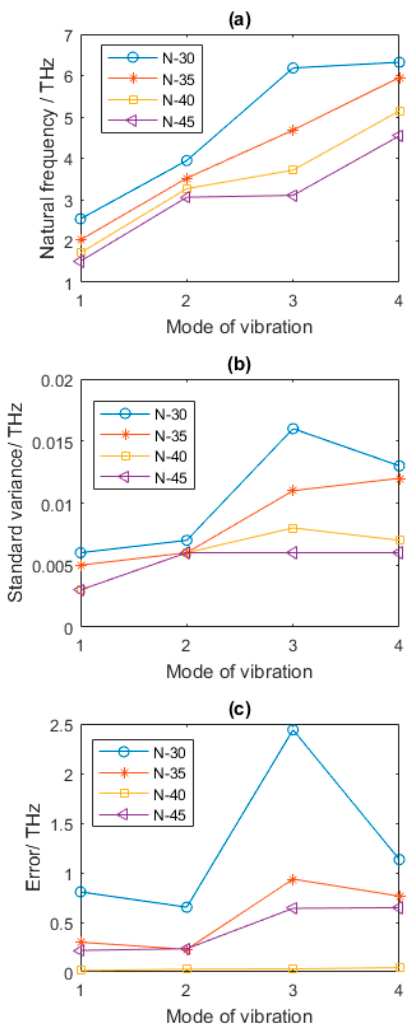
Figure 8. Statistical results of defected graphene sheets with different N ( a – c for mean, standard variance and Error of natural frequency, respectively).